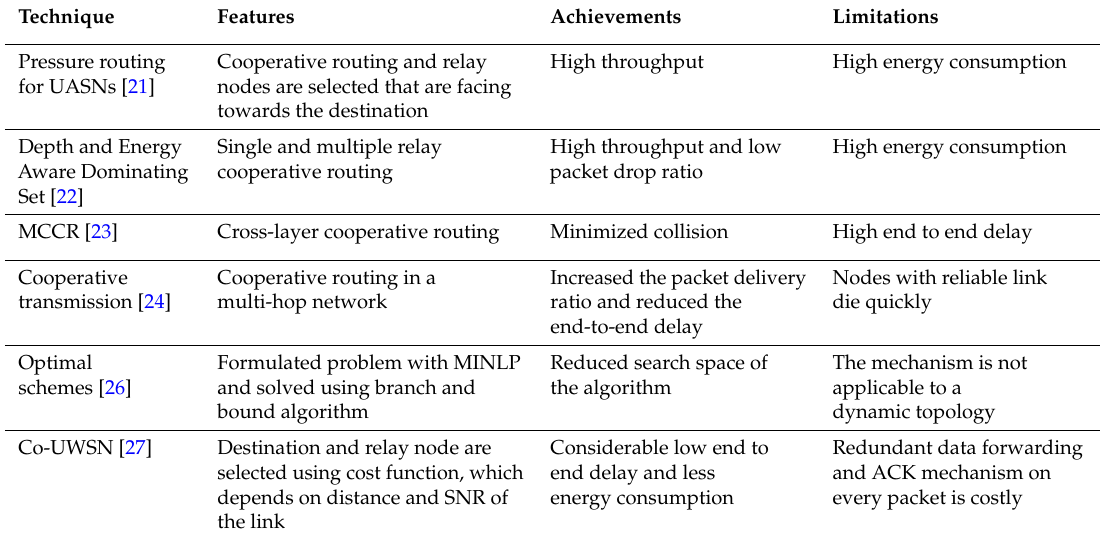
Table 3. Performance tradeoffs in existing cooperation-based routing protocols. UASN, underwater acoustic sensor network; MCCR, minimum collision cooperative